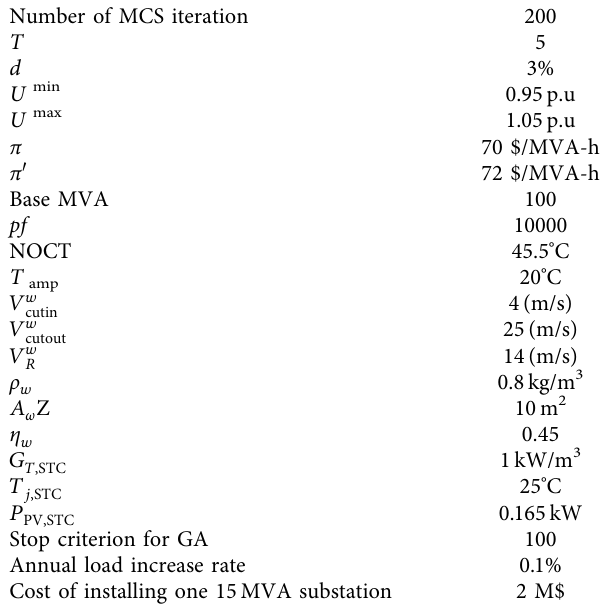
Table 9: Some other parameters of the studied